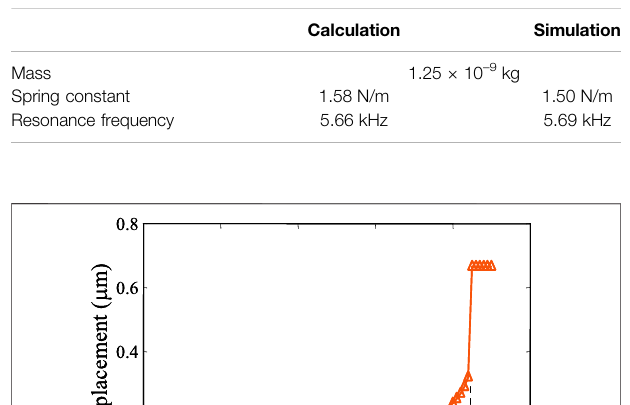
TABLE 2 | Device design parameters.